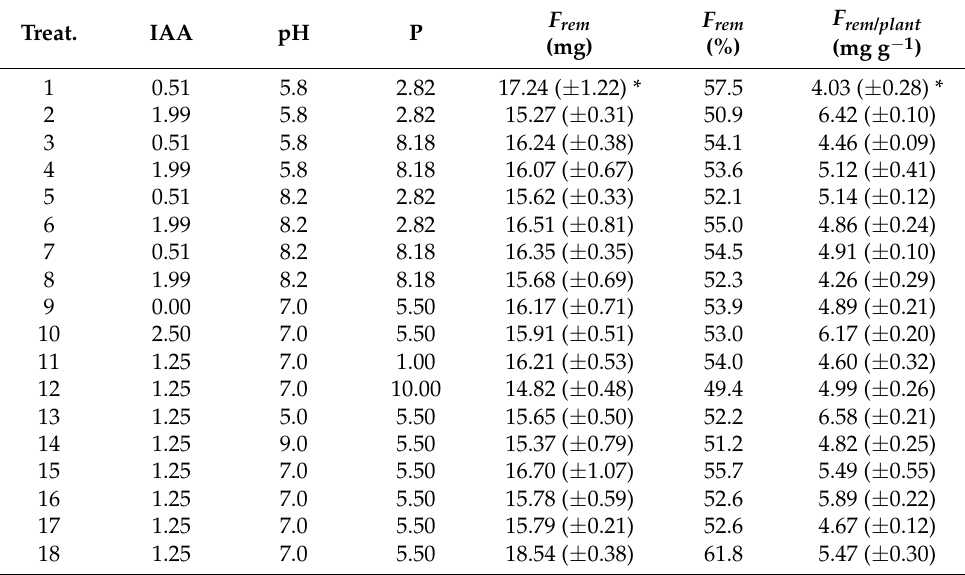
Table 6. Removal of fluoride in mg ( F rem ), percentage ( F rem ( % ) ) and per mass of plant ( F rem / plant , mg g − 1 ) for the central composite design experiment.